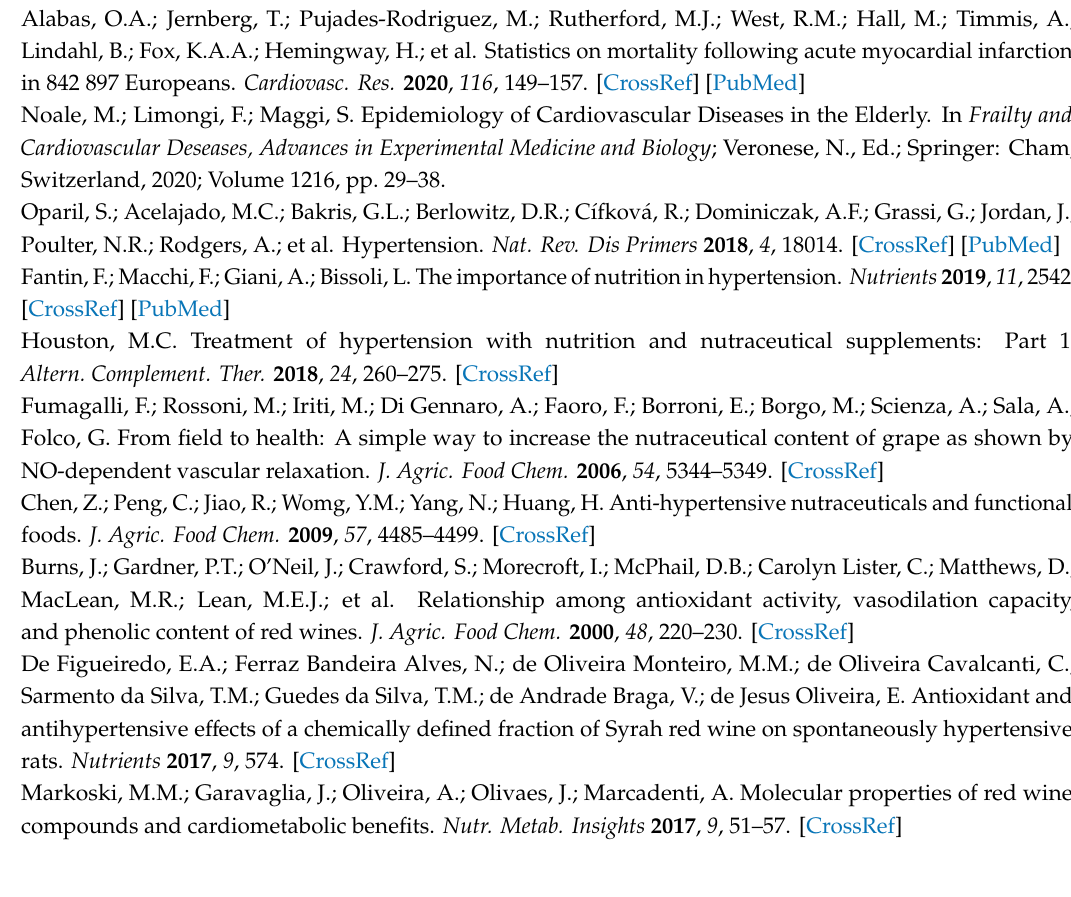
Table S1. 1 H NMR resonance assignment of LDC samples; Figure S1: 1D 1 H NMR spectrum of LDC1; Figure S2: 1 H- 1 H TOCSY NMR spectrum of LDC1; Figure S3: 1D 1 H NMR spectrum of LDC2; Figure S4: 1 H- 1 H TOCSY Figure S7: 1 H- 1 H TOCSY NMR spectrum of LDC5; Figure S8: 1D 1 H NMR spectrum of